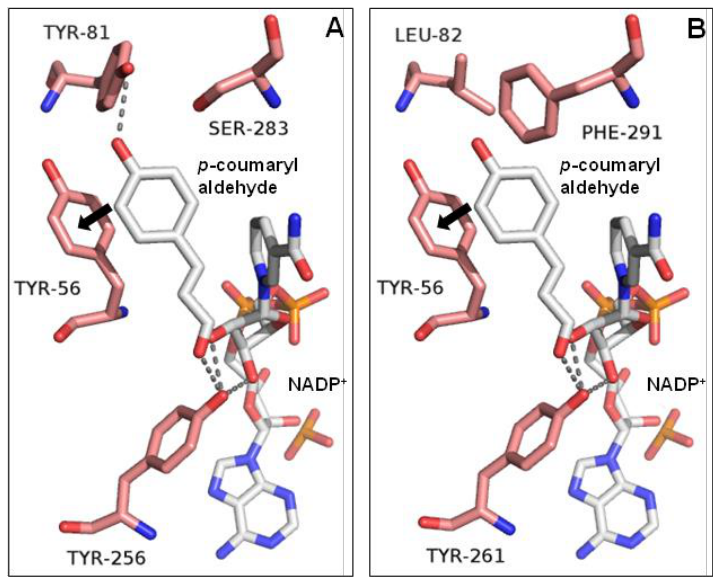
Figure 5. The active site of ( A ) MpDBR, ( B ) MpMDBRL in a complex with NADP + / p -coumaryl aldehyde. Arrows indicate the potential stacking interaction between phenol rings. Hydrogen bonds shown as dashed lines.